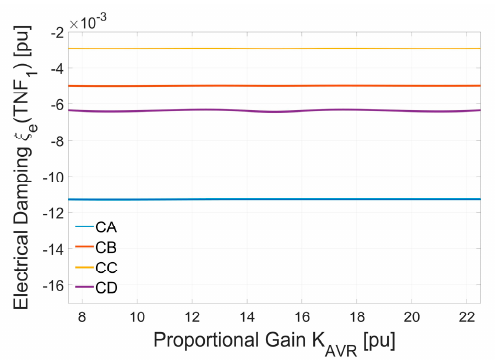
Figure 20. Electrical damping ξ e (TNF 1 ) related to K PI variations.